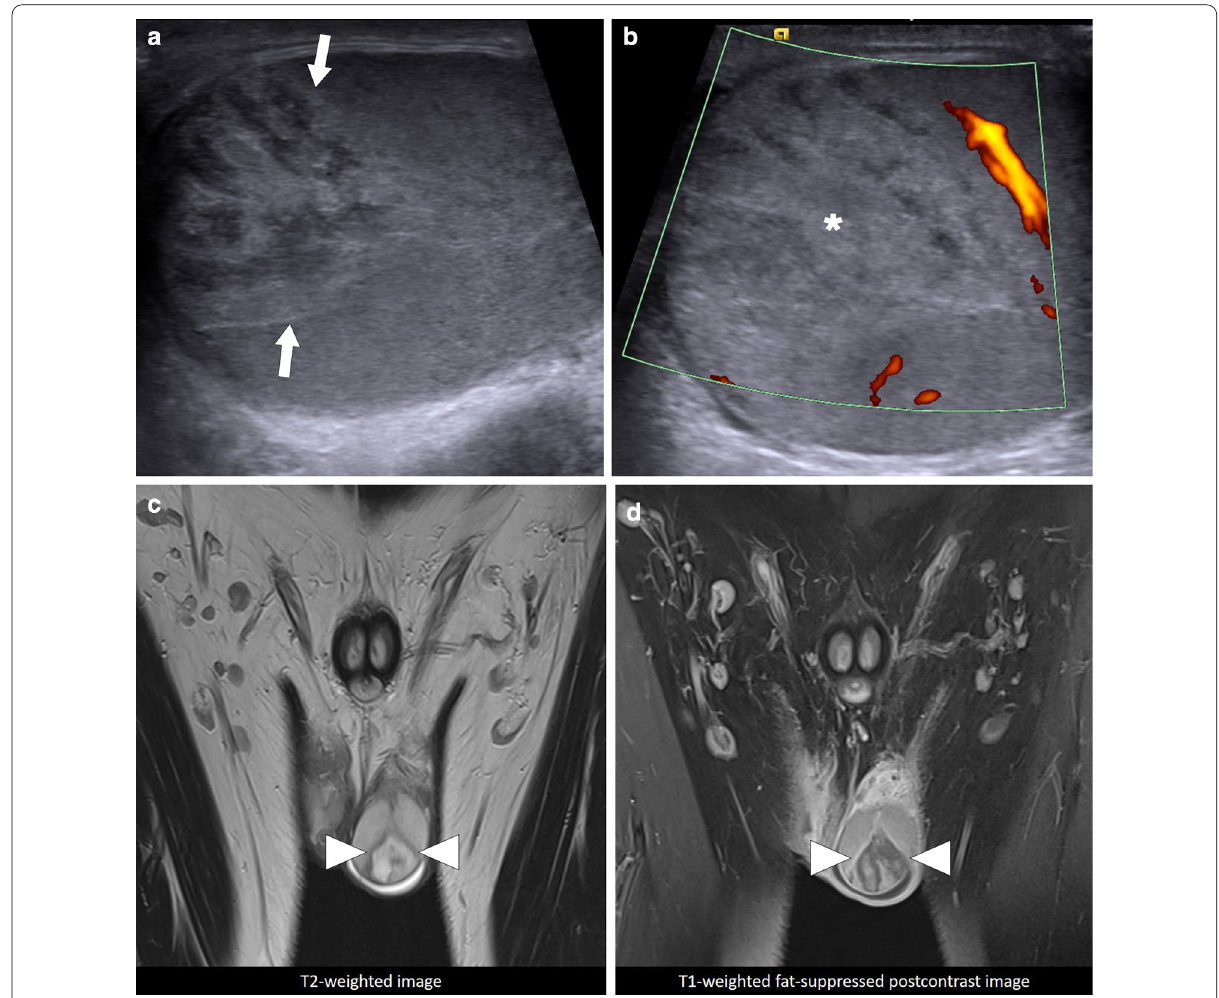
Fig. 16 Segmental testicular infarction. A 32-year-old male with known Behcet’s disease presenting to the ER with left testicular pain. There was no history of trauma. a Gray scale US shows a triangular heterogeneous hyperechoic lesion (arrows) within the left testis. b On Power mode Doppler US, there was no vascularity within this focal area (asterisk). c Coronal plane T2W MR image shows triangular heterogeneous hyperintense lesion with a T2 hypointense rim. d Coronal plane postcontrast MR image demonstrates a hypoenhancing, wedge-shaped parenchymal area with sharp borders. Imaging findings were considered to be consistent with segmental testicular infarction, likely related to Behcet’s disease. Patient was placed on supportive treatment, to which he responded well. Serial follow-up US examinations revealed almost-complete resolution within 3 weeks after the initial